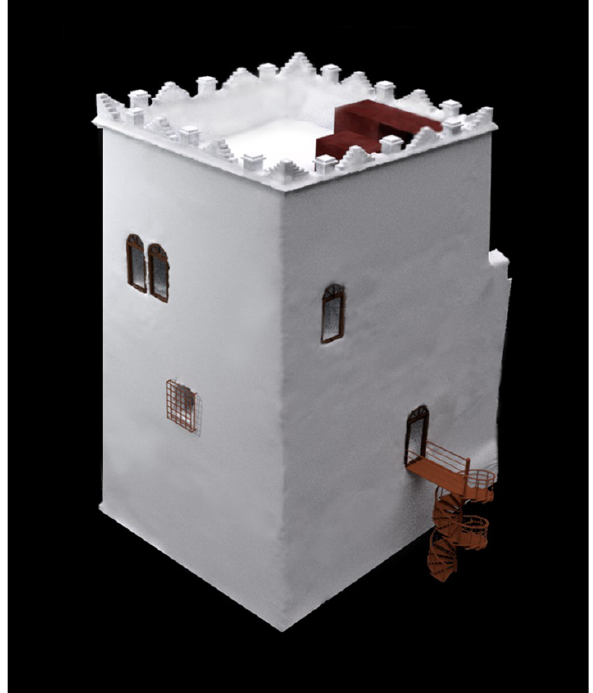
Figure 8. Graphic proposal of the intervention